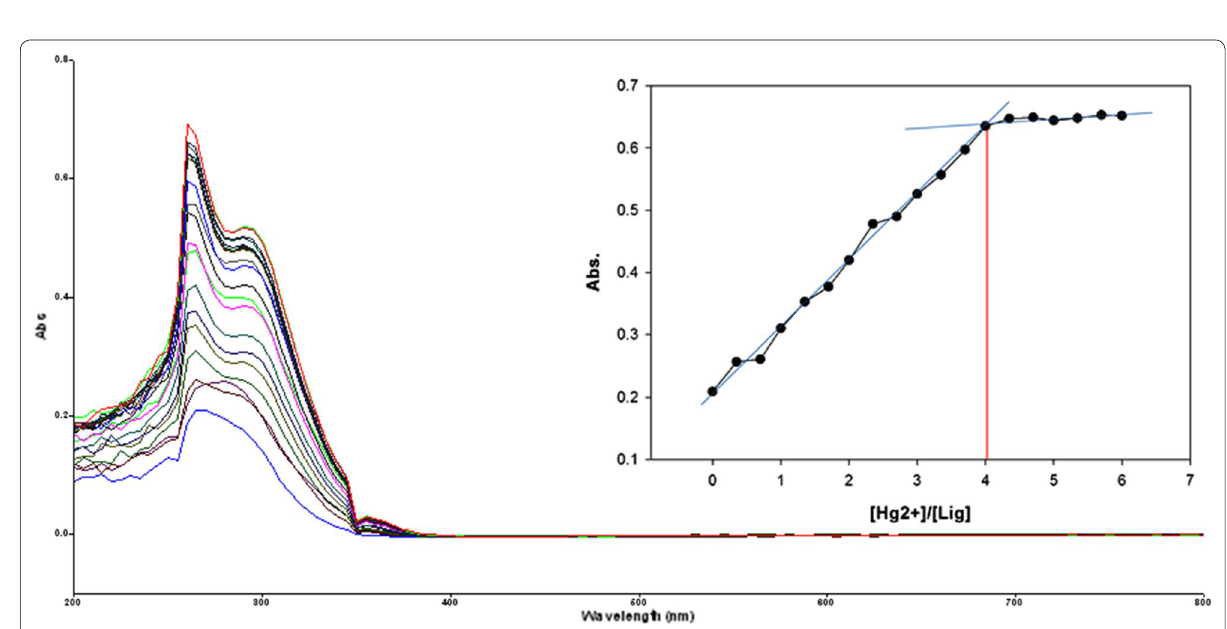
Fig. 14 Titration of isomer 1A vs Hg 2 + ( Inset Binding behavior